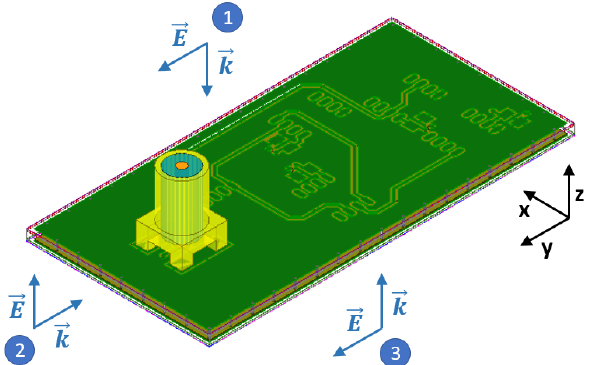
Figure 7. Four-layer practical PCB with two separate incident wave scenarios. The practical design includes component footprints and traces on the top layer as well as a surface mount sub-miniature version A (SMA) connector model for experimental